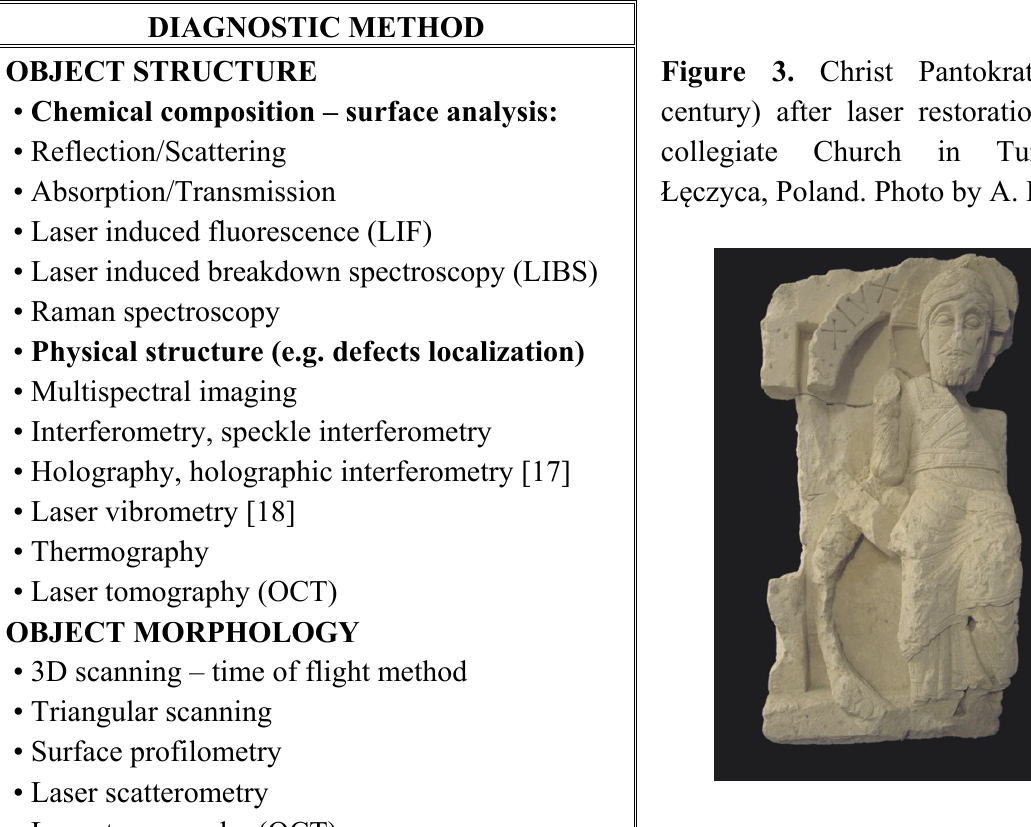
Table 2. Lasers and optoelectronics in nondestructive analysis and diagnostics of monuments and artworks.